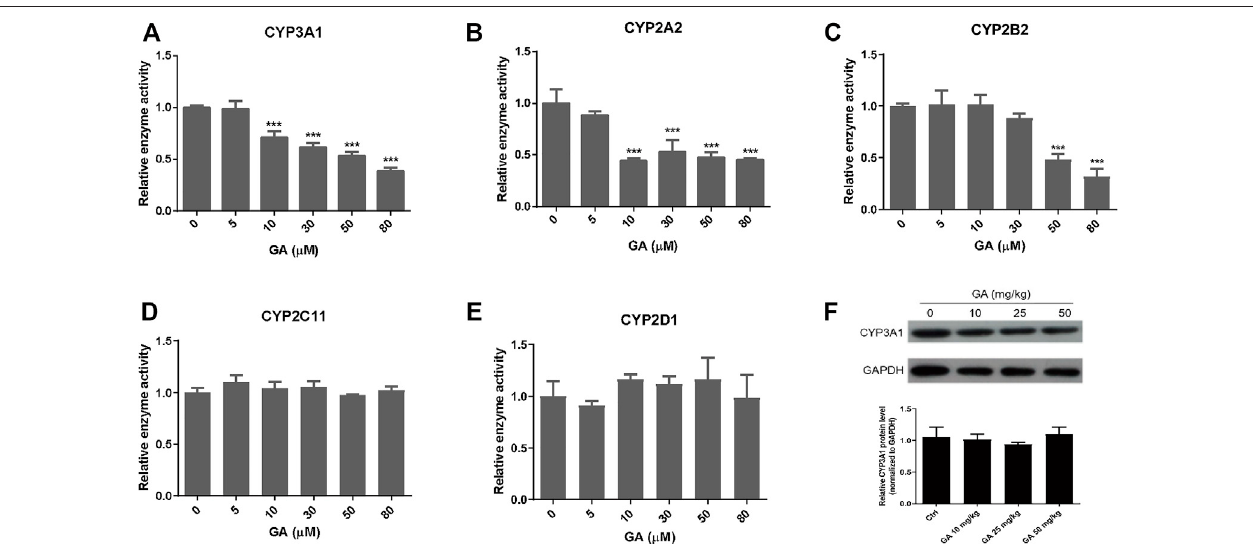
FIGURE6 | The effect of GAon theactivity and expression ofCYPs. (A – E) Inhibitory effects ofGA on the activities ofCYP3A1, CYP2A2, CYP2B2, CYP2C11, and CYP2D1 measured by cocktail assay in vitro . (F) Protein expression of CYP3A1 in the liver measured by western blot. Speci fi c band intensity was quanti fi ed and normalized to GAPDH. Rats were orally administrated with different doses of GA (0, 10, 25, 50 mg/kg) for 5 consecutive days and sacri fi ced at 24 h after the last dose. Data are expressed as mean ± SD ( n = 3). *** p < 0.001 versus the corresponding GA (0 µM)